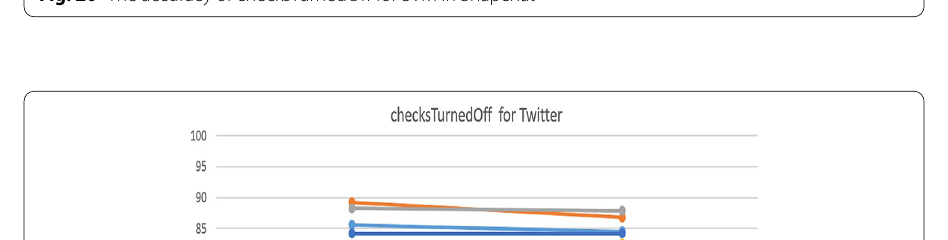
Fig. 20 The accuracy of checksTurnedOff for SVM in Snapchat